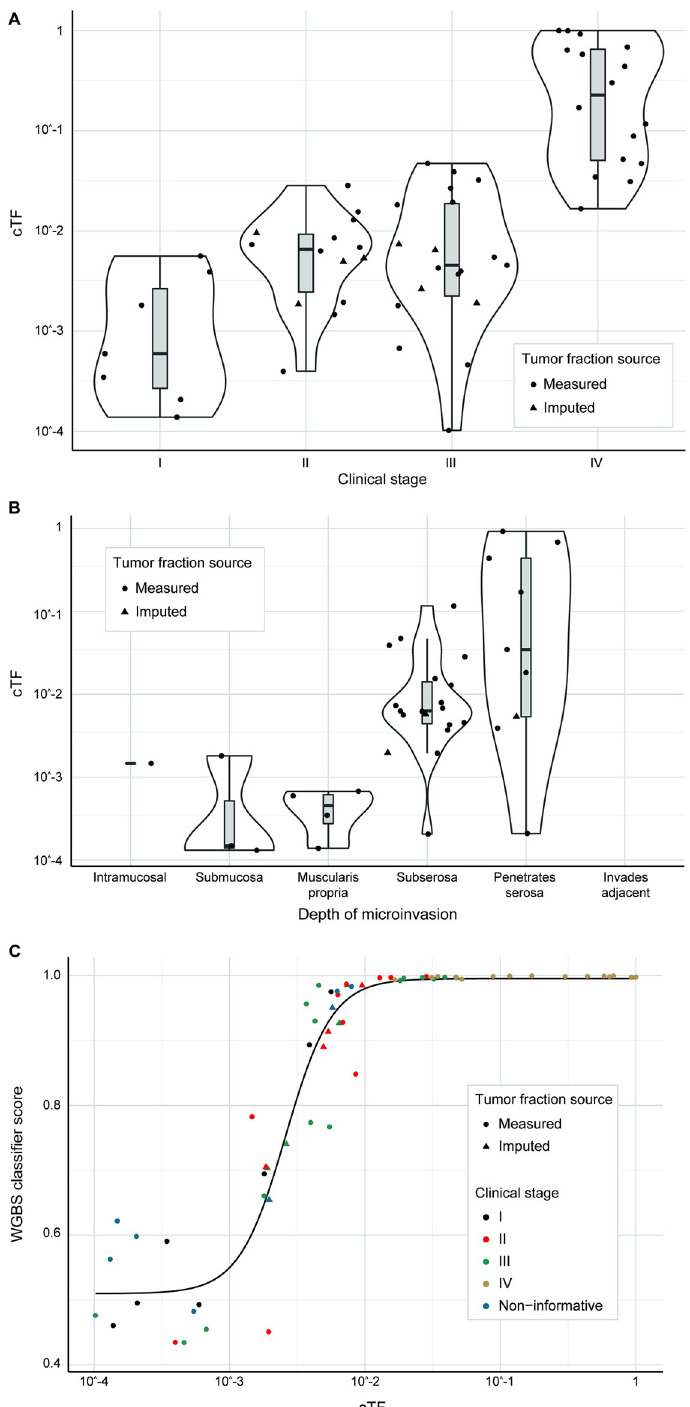
Fig 10. Colorectal cancer cTF distribution by clinical stage, depth of microinvasion, and relation to WGBS classifier score. (A) cTF by clinical stage for colorectal cancer. (B) cTF by depth of microinvasion for colorectal cancer. (C) WGBS classifier score by cTF for colorectal cancer. Samples are colored by clinical stage and samples with imputed cTF are shown as triangles. cTF: Circulating Tumor fraction, WGBS: Whole-genome bisulfite sequencing. Non- informative: Confirmed invasive cancer with insufficient clinical information to determine